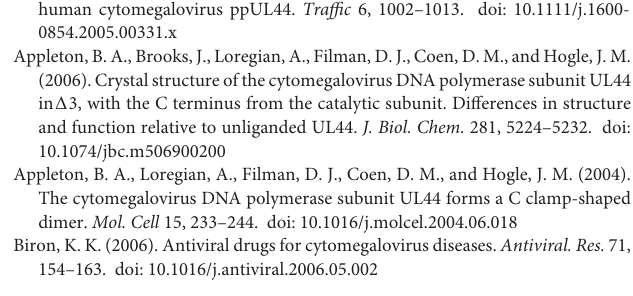
Supplementary Figure 1 | Interaction of UL44 with UBC9 as analyzed by yeast two-hybrid and β -galactosidase assays. The association of p53 and T antigen served as a positive control and the co-expression of Lamin C and T antigen served as a negative control. Supplementary Figure 2 | Both UL44 and UBC9 located in nuclei. Hela cells were transfected with constructs encoding EGFP-UL44 and DsRed-UBC9 alone or together, stained with Hoechst 33258 to visualize cell nuclei. UL44 alone located in nuclei and UBC9 alone mainly located in nuclei. Supplementary Figure 3 | Co-IP of transiently expressed UL44 and UBC9. 293T cells were cotransfected with HA-tagged UL44 and Myc-tagged UBC9 as indicated. Cell lysates were incubated with immobilized anti-Myc beads to isolate UBC9 and its associated proteins. Results were analyzed by western blot using anti-HA and anti-Myc antibodies. Representative of three independent experiments. Supplementary Figure 4 | Effects of antibiotics resistance cassette insertion on the viral replication of HCMV in HFFs. (A) Schematic for BAC construction and generation of wild-type, mutant and revertant HCMV virus. (B) The replication and spread abilities of HCMV were determined by multi-step virus growth curves. HFF cells were infected by appropriate virus (WT, UL44WT-Zeo, UL44-K410A-Zeo, and WT-Rev-Kana) at a moi of 0.1 and collected at the indicated time points. Released virus at each time point was titrated on HFFs by serial dilutions and plaques counting to generate growth curves. Titration of each time point was done in triplicate and titer values were means from triplicate experiments. Note that introduction of antibiotics resistance cassette downstream of UL44 loci could enhance the viral replication comparing to WT